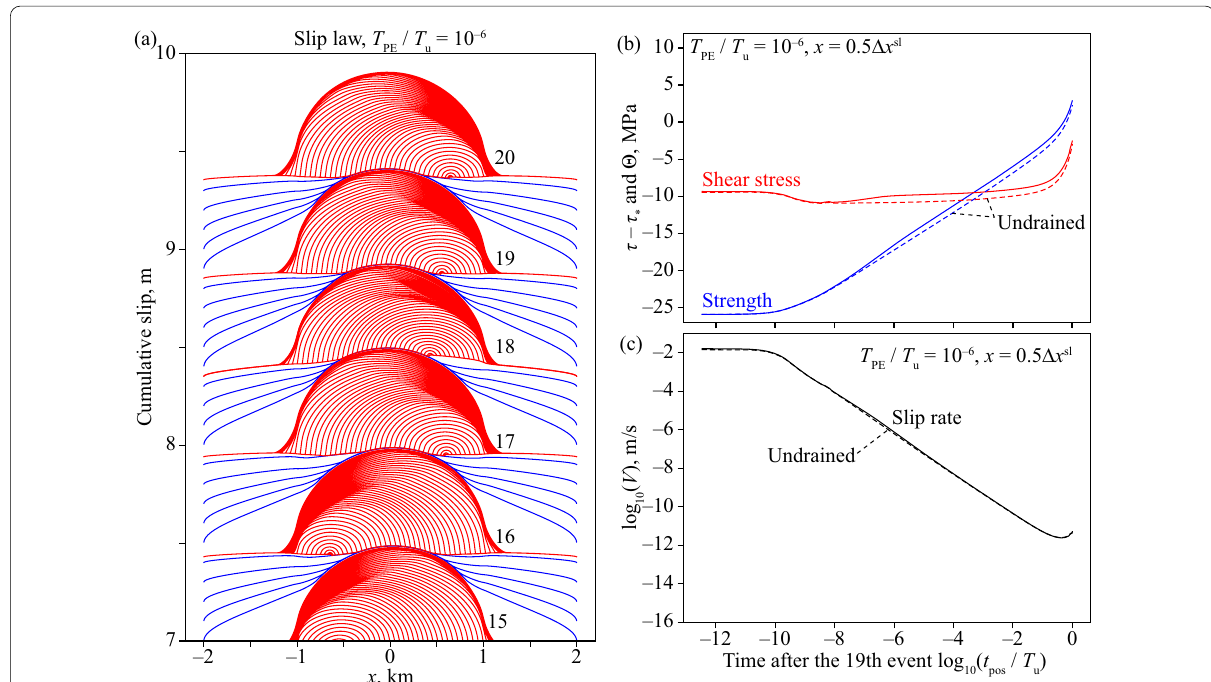
Fig. 9 Example simulation with PE for a fault governed by the aging law. a Cumulative slip distribution, blue: every 10 8 s , red: every 0.02s during earthquakes. Integers indicate ordinal numbers of earthquakes in the simulated sequence. b Shear stress (red) and strength (bule) of the fault relative to the reference at x = 0.5 � x sl = R / 2048 as a function of time after the 19th earthquake. c Slip rate near the center, x = 0.5 (cid:31) x sl as a function of time after the 19th